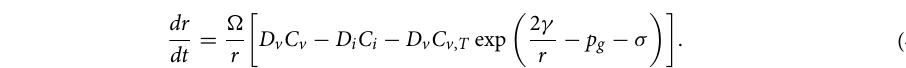
Figure 3. Comparison of the net vacancy absorption and thermal vacancy emission components of cavity growth for dual ion irradiation assuming ( a ) homogeneous nucleation and ( b ) the inclusion of a stress-assisted